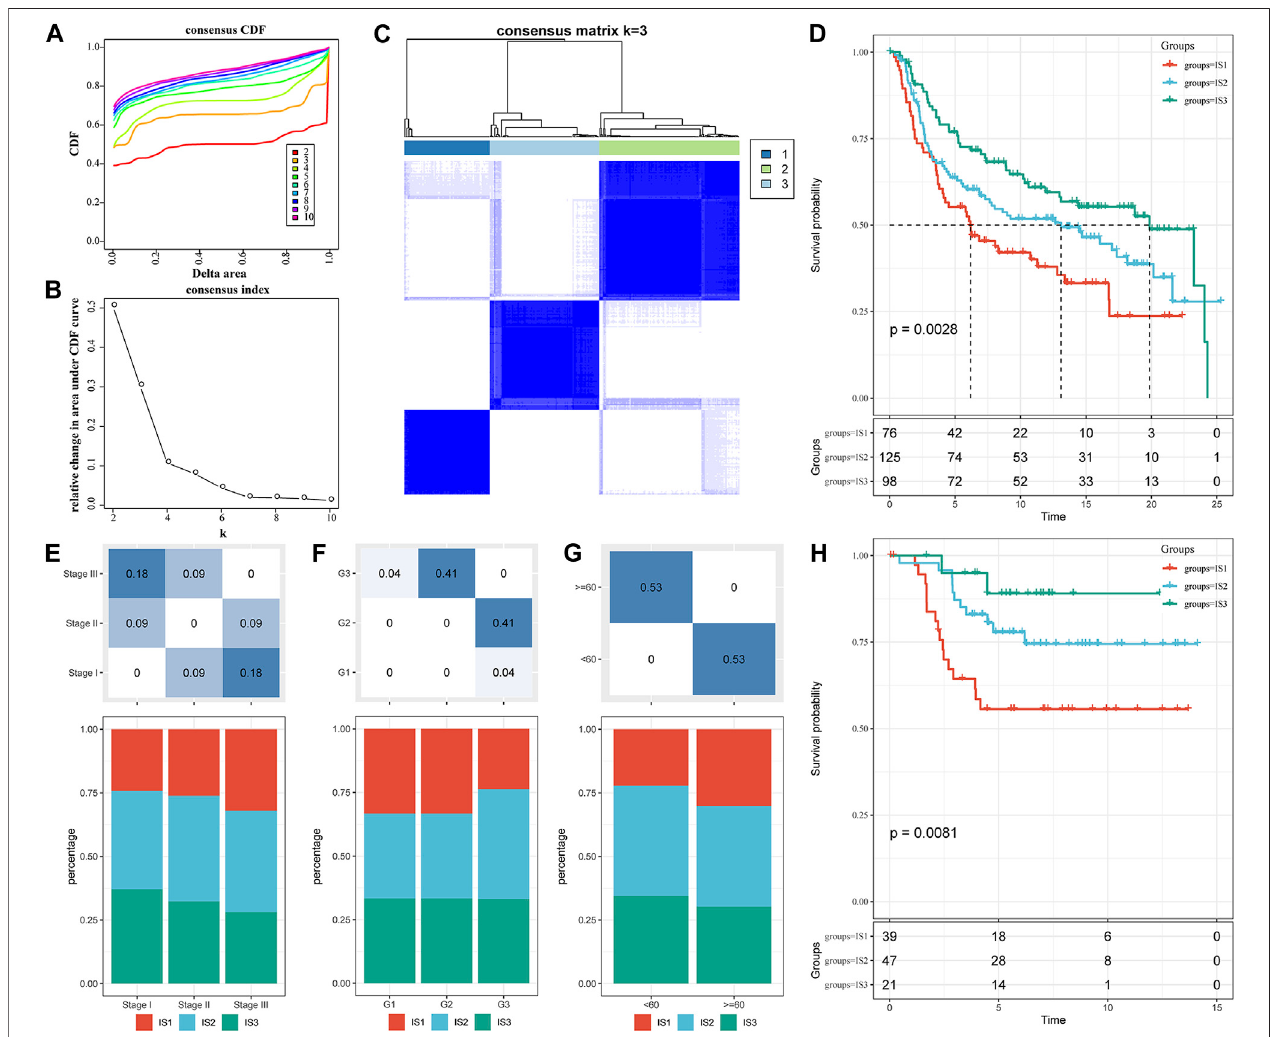
FIGURE 1 | The immune subtypes in the METABRIC-TNBC cohort. (A) CDF curves of the METABRIC-TNBC cohort samples. (B) CDF Delta area curve of the METABRIC-TNBC cohortsample.TheDeltaareacurve oftheconsensusclusteringindicatestherelative changeinareaunderthecumulativedistribution function(CDF) curve for each category number k compared with k − 1. The horizontal axis represents the category number k, and the vertical axis represents the relative change in area under the CDF curve. (C) Consensus matrix, the heat map of sample clustering when k (cid:1) 3. (D) KM curve of the prognosis among the three immune subtypes. (E) Proportion of immune molecular subtypes in different stages of the METABRIC-TNBC cohort. (F) Proportion of immune molecular subtypes in different grades of the METABRIC-TNBC cohort. (G) Proportion of immune molecular subtypes in different ages of the METABRIC-TNBC cohort. (H) Prognostic differences among the three immune molecular subtypes in the GSE58812 cohort. The lower part is the proportion, and the upper part is the distribution difference between the two parts, with a statistical signi fi cance of p (cid:1) − log10.